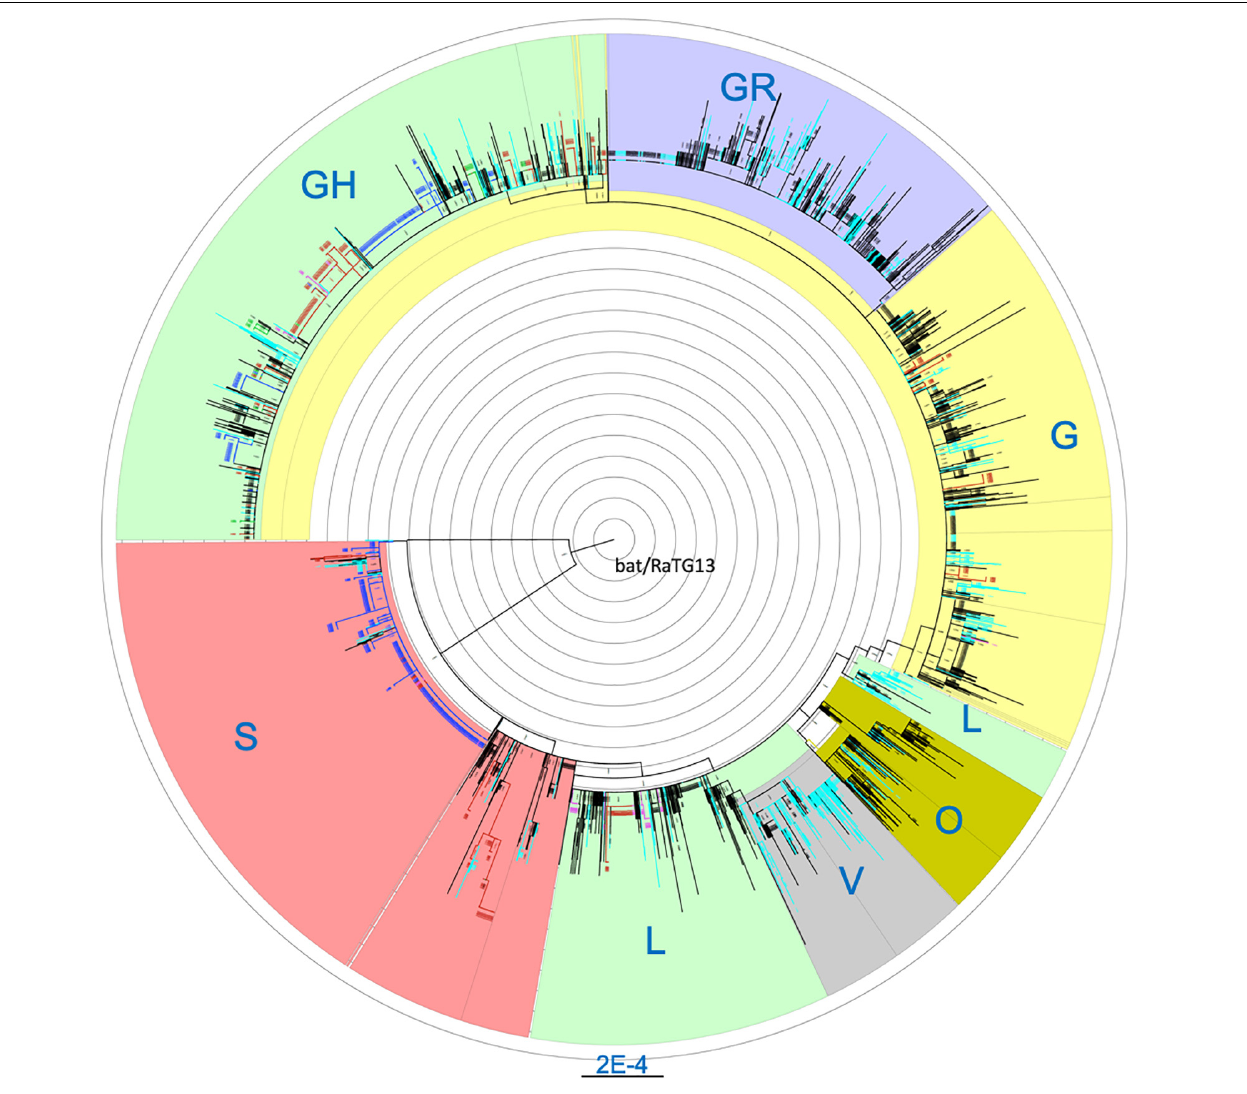
FIGURE 1 | Maximum likelihood phylogenetic tree of isolates carrying US-specific haplotypes and 2,000 randomly selected non-US isolates. Blue, isolates with Washington-specific haplotypes; Pink, Children’s Hospital Los Angeles (CHLA) and other California isolates; Green, New York-specific, Red, other states’ isolates with USA-specific haplotypes; Light blue, UK and Australia isolates; Black, Other non-US isolates. Blue labels, the clade names. A total of 1107 isolates from US-specific haplotypes were included in the phylogenetic analysis. Non-US isolates belonging to any haplotypes were randomly sampled at about 10% to reach 2000 isolates. Each branch in the phylogenetic tree may represent a group of isolates. The tree is rooted at the outgroup MN996532 (EPI_ISL_402131,